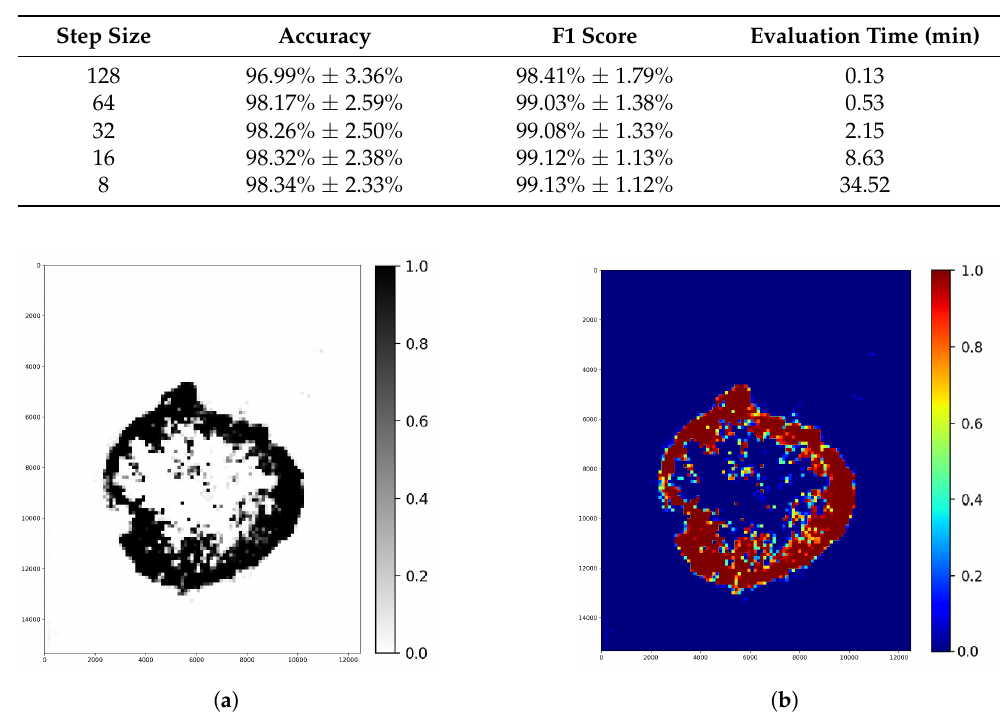
Figure 12. Whole image (Figure 11a) segmentation displays the evaluation before optimizing the parameters. In this case, there is no overlapping, so the pixel value came from a one-tile prediction of each tile. Colors around the 0 confidence value means healthy, and around 1 means tumor tissue region. ( a ) Segmentation result (Binary colormap). ( b ) Segmentation result (Jet colormap).